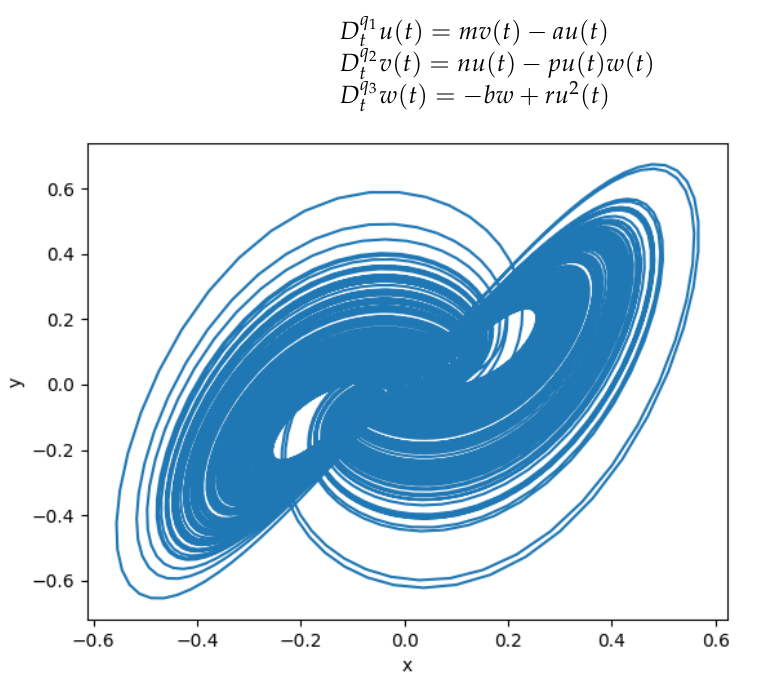
Figure 4. Liu attractor after scaling to allow CMOS design. Table 4. The scaling parameters m , n , p , r introduced by (9) provide maximum amplitudes of x , y , z within ± 0.74, while maintaining the values of the associated D KY .